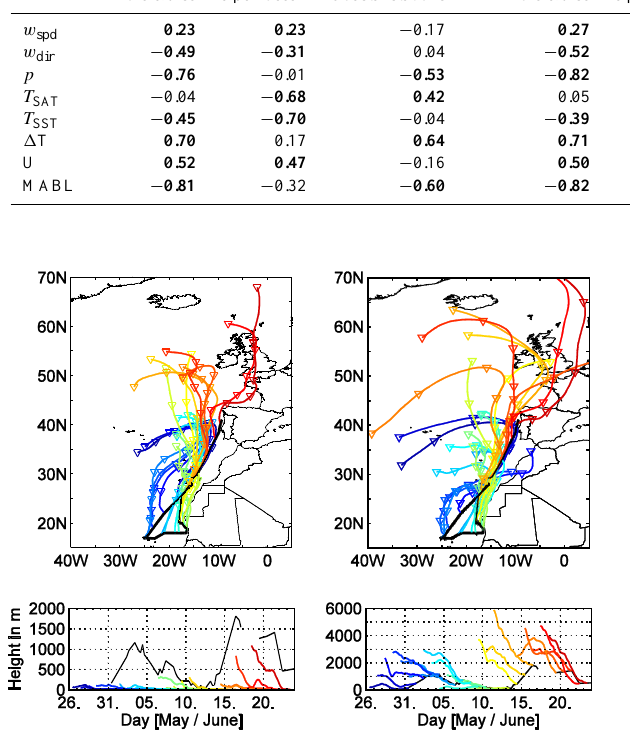
Fig. 10: HySplit 5-day backward trajectories: initiated at the surface (left side) and at the top of the determined marine atmospheric boundary layer (right side) each day at 12 UTC. The colours of the trajectories indicate the time when the specific trajectory reached the ships position, e.g. blue at the beginning and red at the end of the cruise. The upper plots show the horizontal and the lower plots the vertical distribution of the trajectories. The black line indicates the height of the MABL. Trajectory and MABL heights are given in [m].